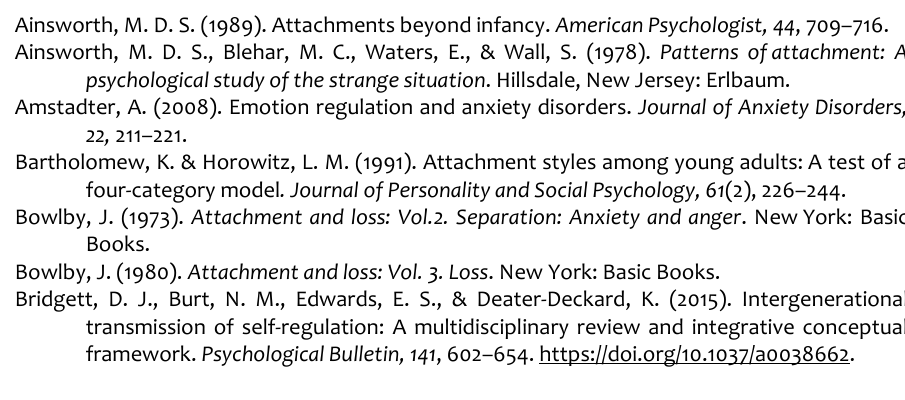
odnos između deteta i roditelja i dovode do bolje emocionalne regulacije kod